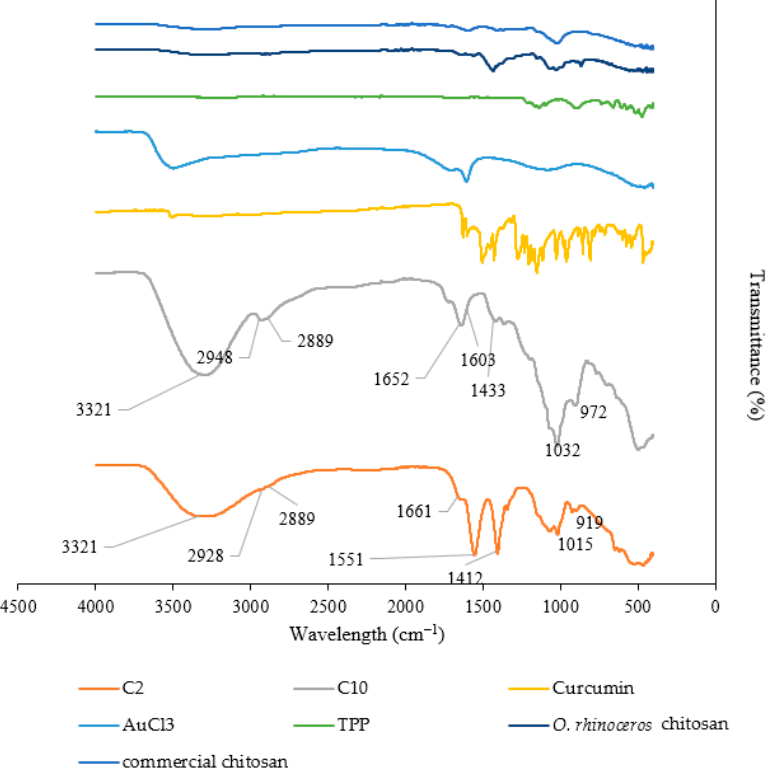
Figure 1. FTIR spectra of C2, C10, curcumin, gold (III) chloride, TPP, O. rhinoceros chitosan, and commercial chitosan.